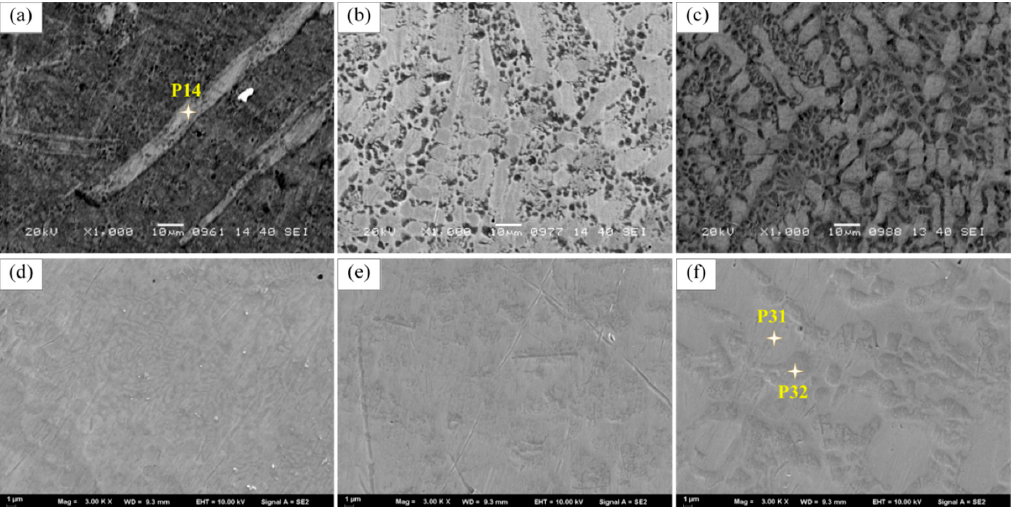
Figure 8. SEM and FE-SEM images of the surface region in the third cladding coatings: ( a , d ) sample LC1; ( b , e ) LC2; ( c , f ) LC3.